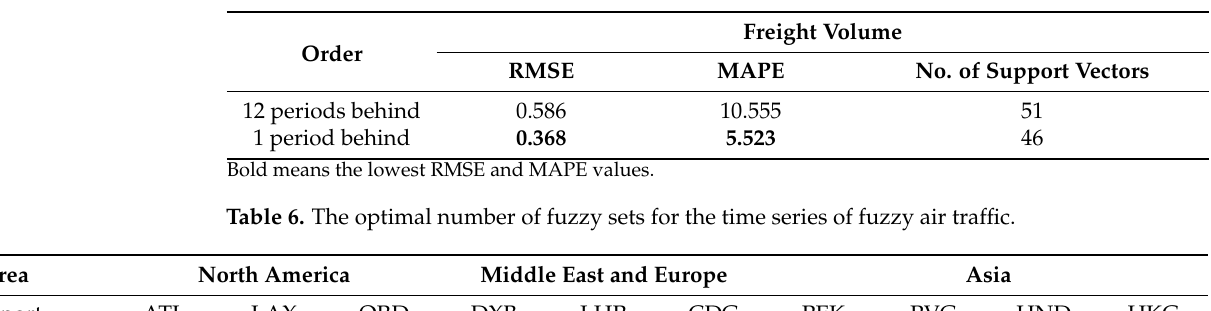
Table 5. Analysis of SVR autoregressive lag periods for air traffic at Atlanta International Airport.